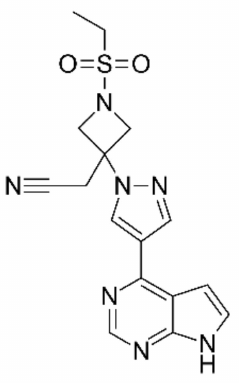
Figure 1. Chemical structure of